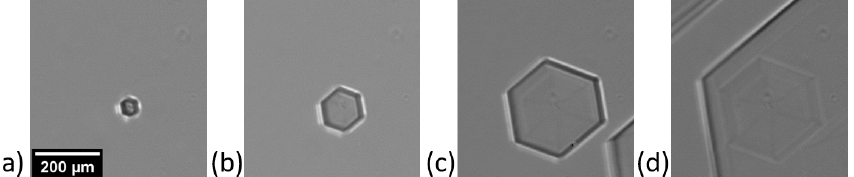
Figure 7. Growth of hexagonal domains in the fields above 21.5 kV/mm. Instantaneous optical images of the domain structure during polarization reversal under the field of 22 kV/mm. The time intervals from the start of field pulse application: ( a ) 220 ms, ( b ) 228 ms, ( c ) 236 ms, ( d ) 244 ms. Optical microscopy, transmitted light.